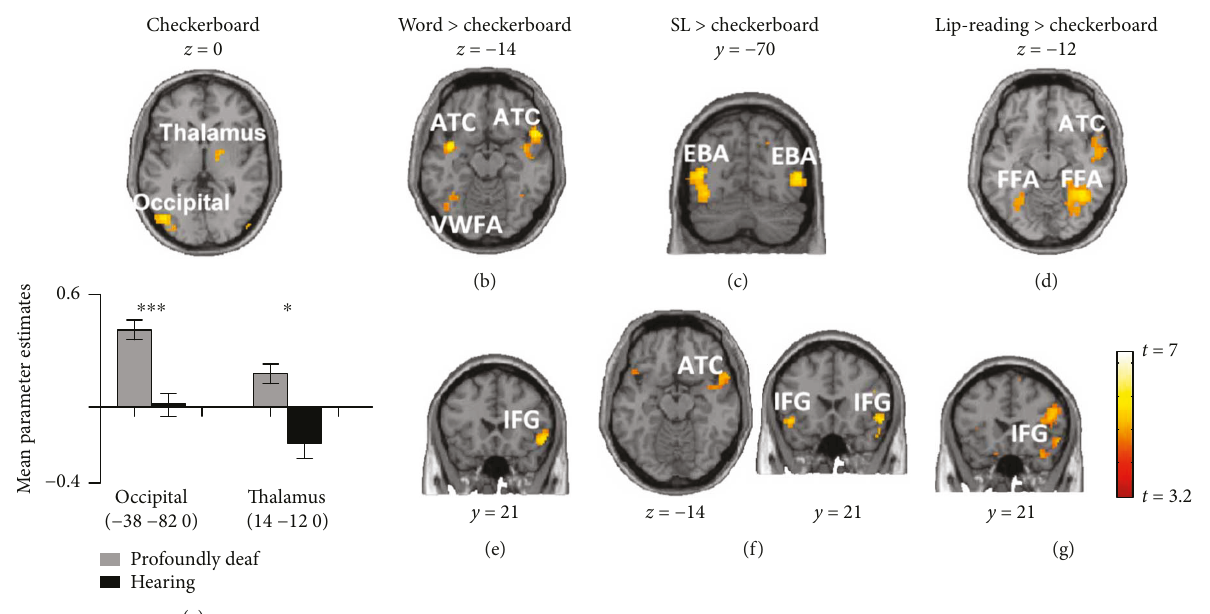
Figure 4: Di ff erences in functional connectivity of the superior temporal cortex (STC) between the profoundly deaf and the hearing groups and between the checkerboard and the language conditions. Brain slices depicting the signi fi cant di ff erences in functional connectivity between the profoundly deaf and the hearing groups ( p < 0 001 , FDR p < 0 05 corrected) with the seed region set in the right STC. For the checkerboard stimulus (a), signi fi cantly enhanced functional connectivity between profoundly deaf and hearing subjects was found in the left occipital cortex and right thalamus. In comparison with the checkerboard (whole brain, p < 0 001 , FDR p < 0 05 corrected), for the word condition (b, e), greater connectivity was shown in the visual word form area, bilateral anterior temporal cortex, and right inferior frontal gyrus. For sign language (c, f), the bilateral extrastriate body area, right ATC, the bilateral FFA, and the bilateral IFG were identi fi ed as having strong functional connectivity with the right STC. For lip-reading stimuli (d, g), the bilateral FFA, right ATC and right IFG showed higher functional connectivity with the right STC. Asterisks denote a signi fi cant di ff erence between the profoundly deaf group and the hearing group. Error bars indicate 1 standard error. ∗∗∗ p < 0 001 and ∗ p < 0 05